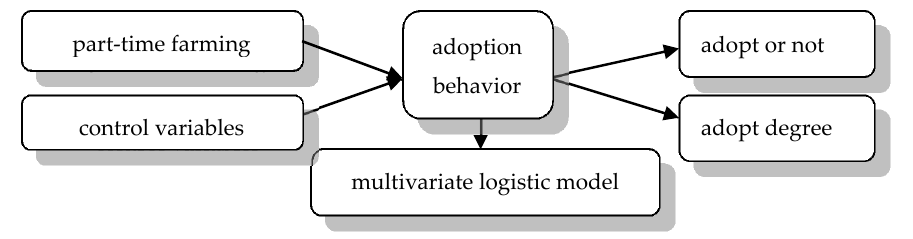
Figure 1. The flow chart of this paper.